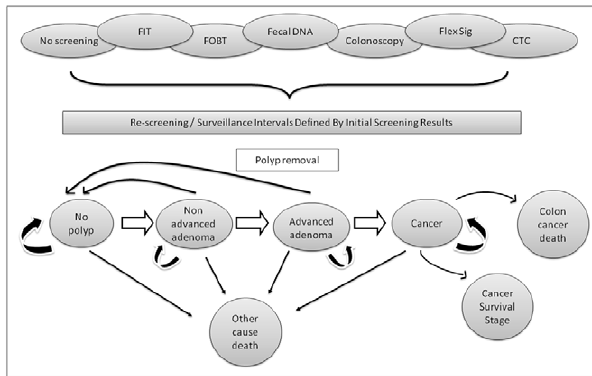
Figure 1. Model bubble diagram. This diagram depicts the general health states and flow through the